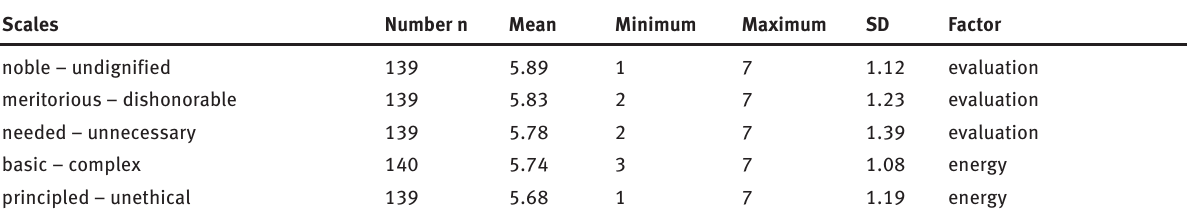
Table 6: Reverse scales with the highest rating